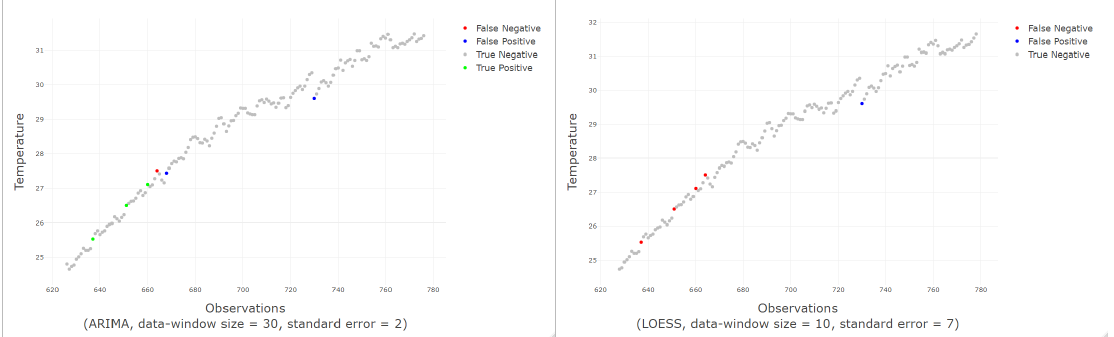
Figure 12. On the left, an example of good classification; on the right, an example of bad